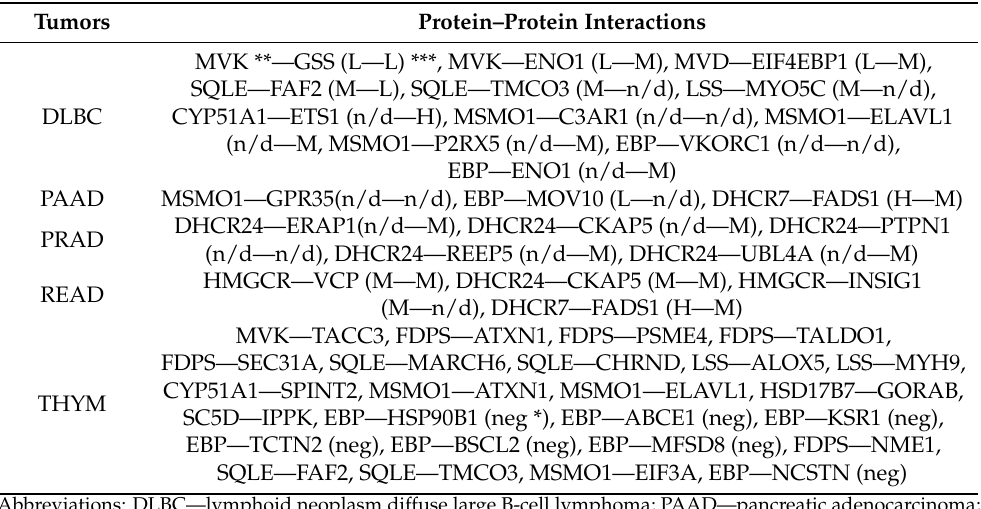
Table 3. Gene co-expression analysis of protein–protein interactions.